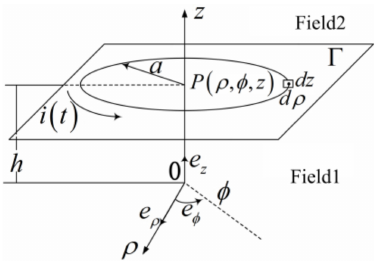
Figure 4. Schematic of a